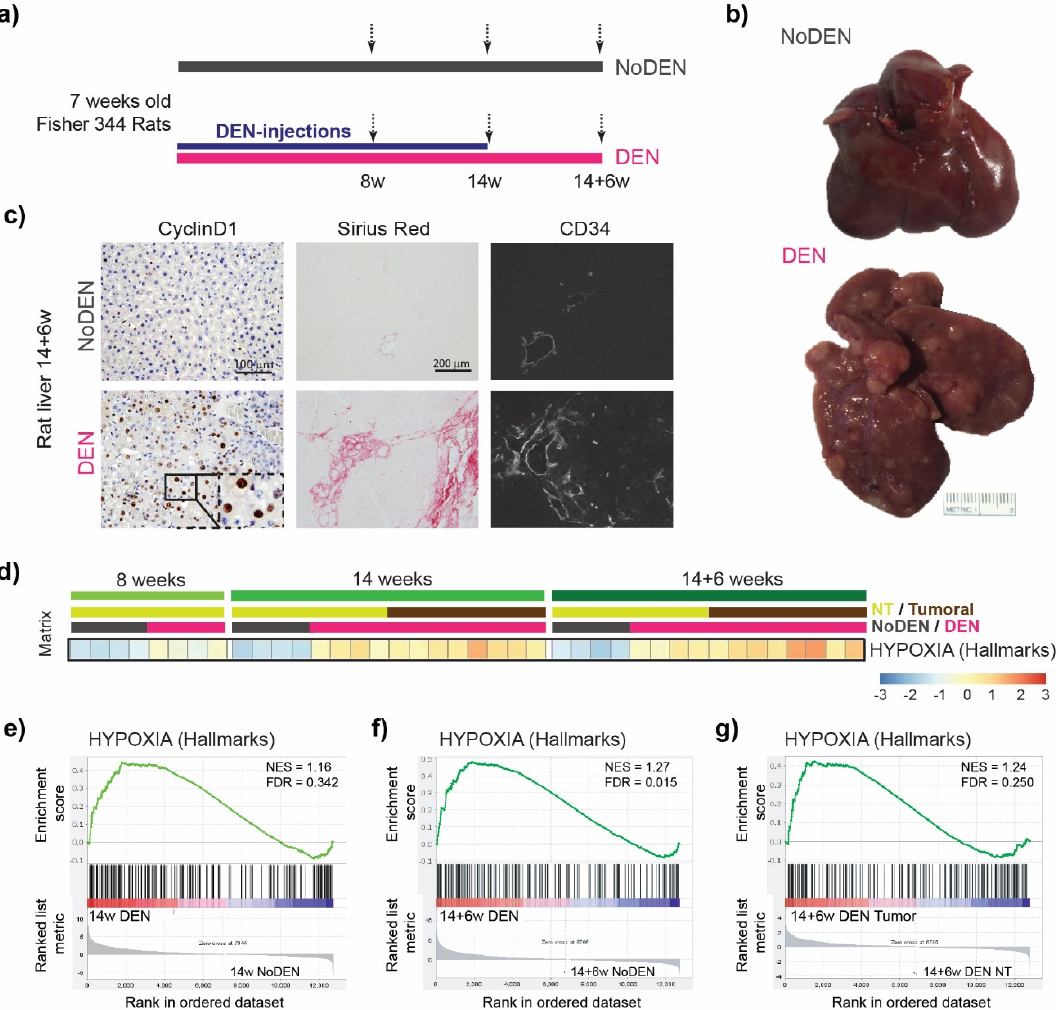
Figure 1. Chronic DEN-induced hepatocarcinogenesis is associated with hypoxia. ( a ) Timeline protocol of the DEN-induced cirrhotic rat model of HCC. Seven-week-old Fisher 344 rats were injected weekly by DEN (50 mg/kg per week); 8 w indicates 8 weeks of DEN injections, 14 w indicates 14 weeks of DEN injections, and 14 + 6 w indicates 14 weeks of DEN injections followed by 6 weeks of no DEN injections. The arrows indicate the day of tissue harvest. ( b ) Representative pictures of the liver at 14 + 6 w from the rat without DEN treatment (upper panel) and the rat chronically treated with DEN (lower panel). ( c ) Representative images of the liver from rats untreated (upper panels) or treated with DEN injections (as above, lower panels). Histopathological sections stained with nuclear Cyclin D1 (20× magnification, left panels), with Sirius red (middle panels), and with anti-CD34 immunofluorescence (right panels). ( d ) Heatmap showing the single-sample Gene Set Enrichment Analysis (GSEA) scores for the Hypoxia Hallmarks gene set. ( e – g ) GSEA plots of differentially expressed genes from livers of DEN-treated versus untreated (NoDEN) rats at 14 weeks (( e ): non-tumor tissue) and 14 + 6 weeks (( f ): non-tumor tissue, ( g ): tumor tissue), showing the enrichment of genes associated with the response to low oxygen levels (Hypoxia-Hallmarks). NES, normalized enrichment score; FDR, false discovery rate; w, weeks.